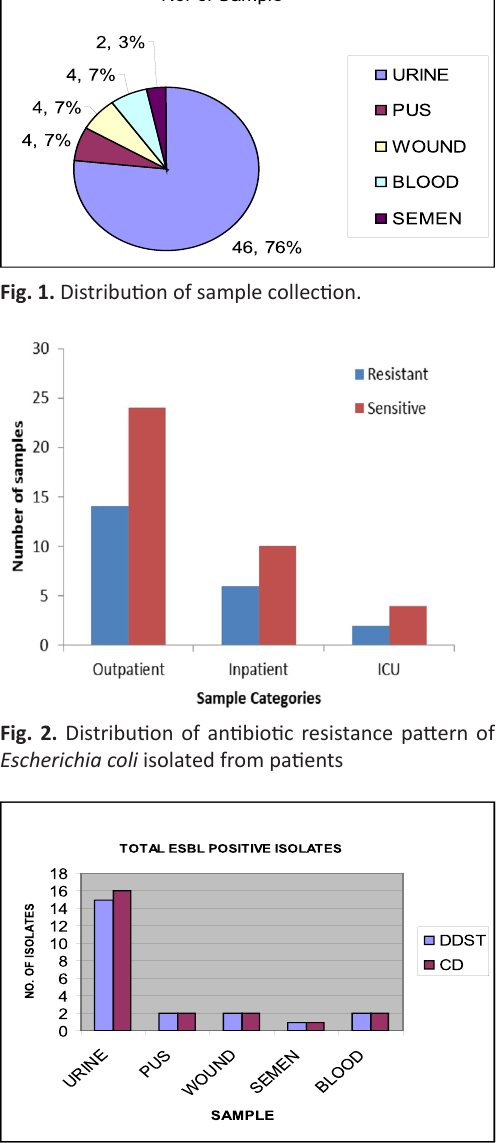
Fig. 3. Extended spectrum beta- lactamases producing isolates from various samples using phenotypic methods Double Disk Synergy Test( DDST ) and Combined Disc Test (CD )